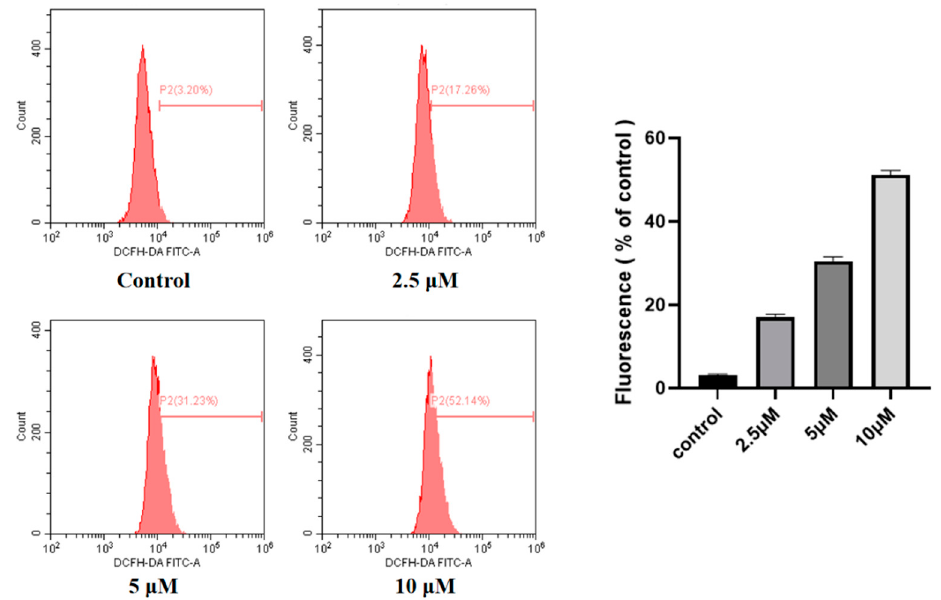
Figure 6. Effects of hybrid A8 on the ROS level of MCF-7 cells. MCF-7 cells treated with A8 at the concentrations of 0, 2.5, 5 and 10 μ M for 48 h and loaded with DCFH-DA fluorescent probe before analysis.